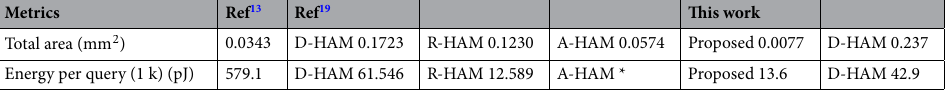
Table 1. Energy and area metrics of our proposed time-domain RRAM-CAM HAM design and D-HAM compared to references normalized to: 65 nm, d = 1 k, and 10